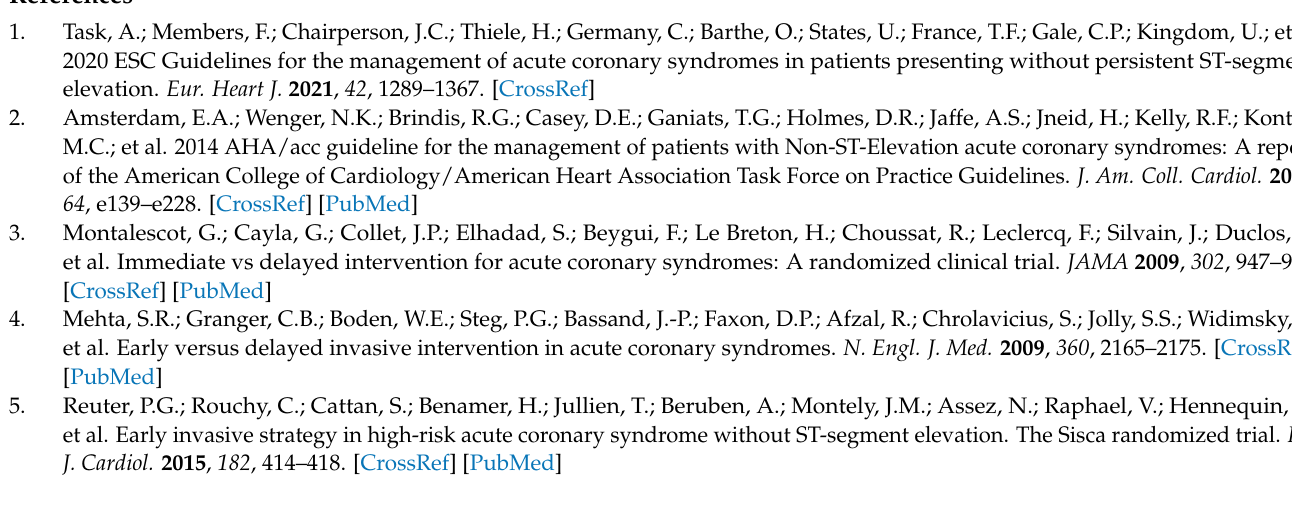
Supplementary file 2: Final diagnosis in patients treated conservatively. Supplementary file 3: Comparison of change in ejection fraction and left ventricular global longitudinal strain for PCI- treated